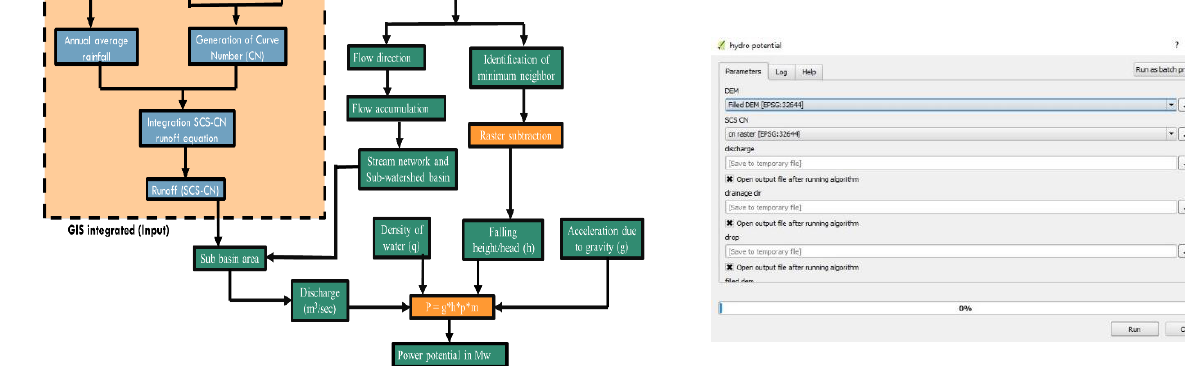
Figure 3(A). Graphical user interface of hydro potential